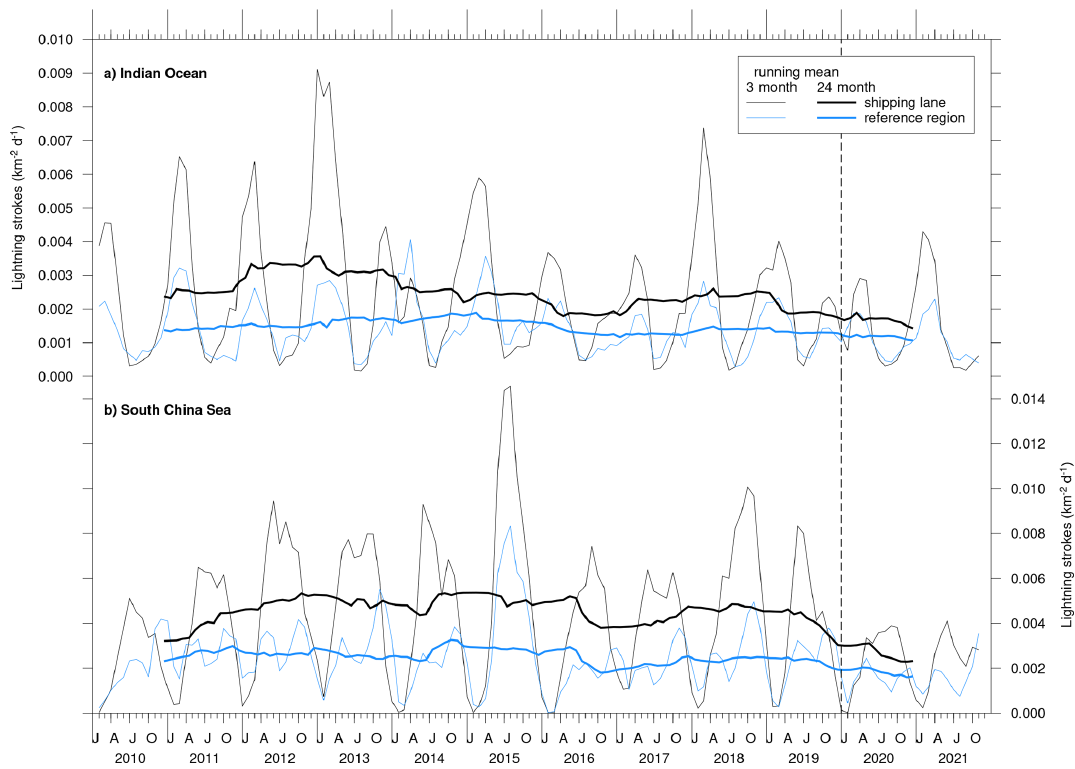
Figure 5. Time series of lightning over the major shipping lanes of the Bay of Bengal and South China Sea and adjacent areas (reference regions) following Thornton et al. (2017). The introduction of the IMO Global Sulfur Cap in January 2020 is marked with a dashed